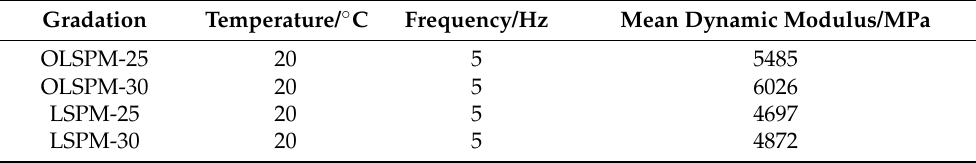
Table 9. Experimental results of dynamic modulus of four different